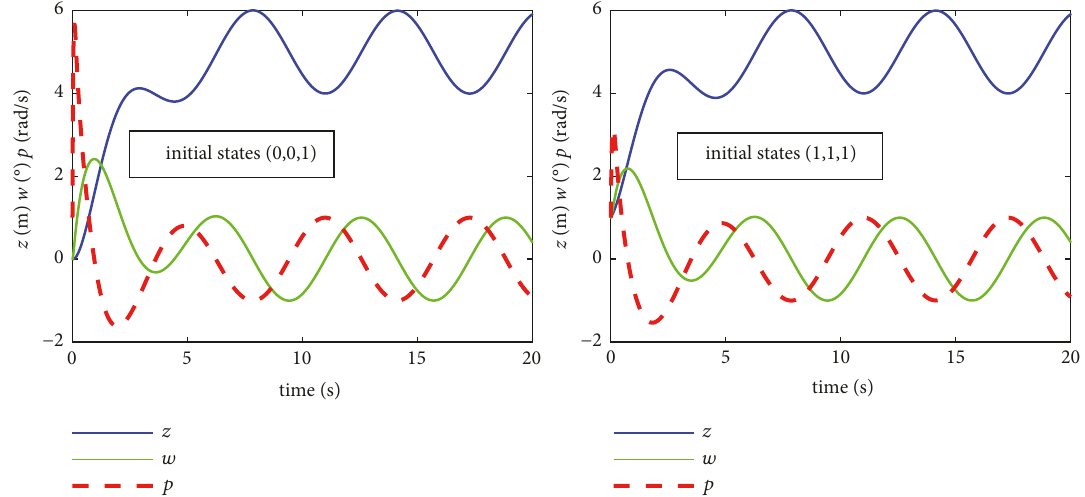
Figure 2: The AUV vertical plane system states [𝑧,𝑤, 𝑝] in the entire simulation interval for the case of initial states as [001] and [111] , respectively.